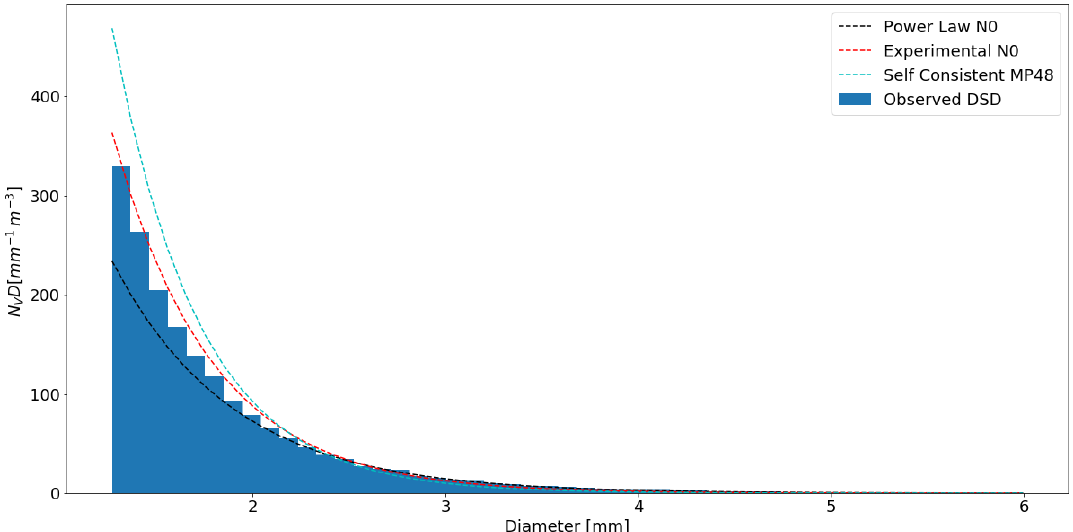
Figure 4. The observed DSD over the entire observational period of the disdrometer is compared to the three parameterisations of the DSD. The self-consistent Marshall and Palmer (1948), the experimentally determined N 0 = 4342 [mm − 1 m − 3 ] and the experimentally determined power law of N 0 . Note that the data should not be extrapolated to the y axis as the x axis is